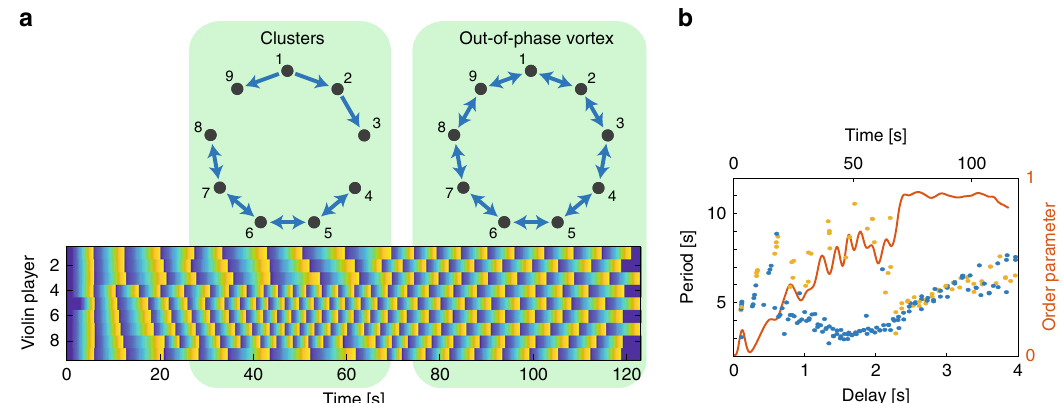
Fig. 6 Nine coupled violin players illustrating an out-of-phase vortex state. a The phase of each player along the musical phrase in one representative measurement as a function of time. Here we see the separation into two clusters, which combine into a single cluster with the checkerboard pattern indicating an out-of-phase synchronization state. b Playing period and out-of-phase order parameter as a function of time and the delay. The order parameter reaches 0.9 due to the vortex, but stays there while increasing the playing period as a function of the delay, indicating a stable state. Yellow dots — the playing period of players 1 – 3, and 9; blue dots — the playing period of players 4 – 8.